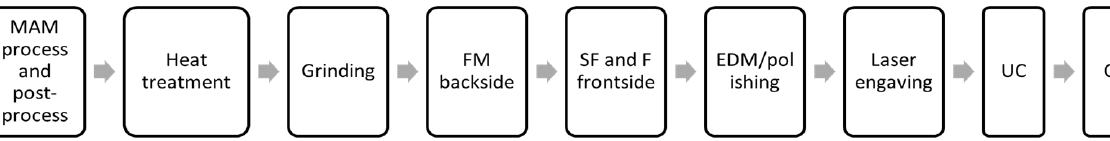
Figure 2. Simplified scheme of the conventional manufacturing process chain.